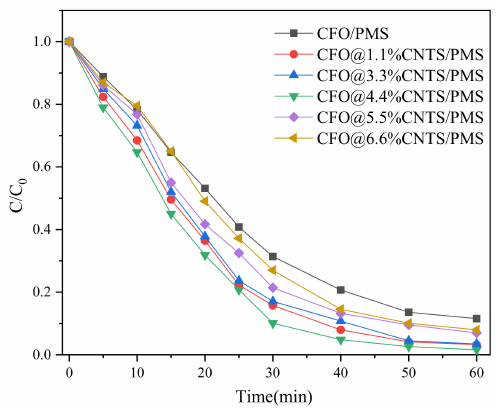
Figure 11. Catalytic breakdown of PMS using varied weight ratios of CoFe 2 O 4